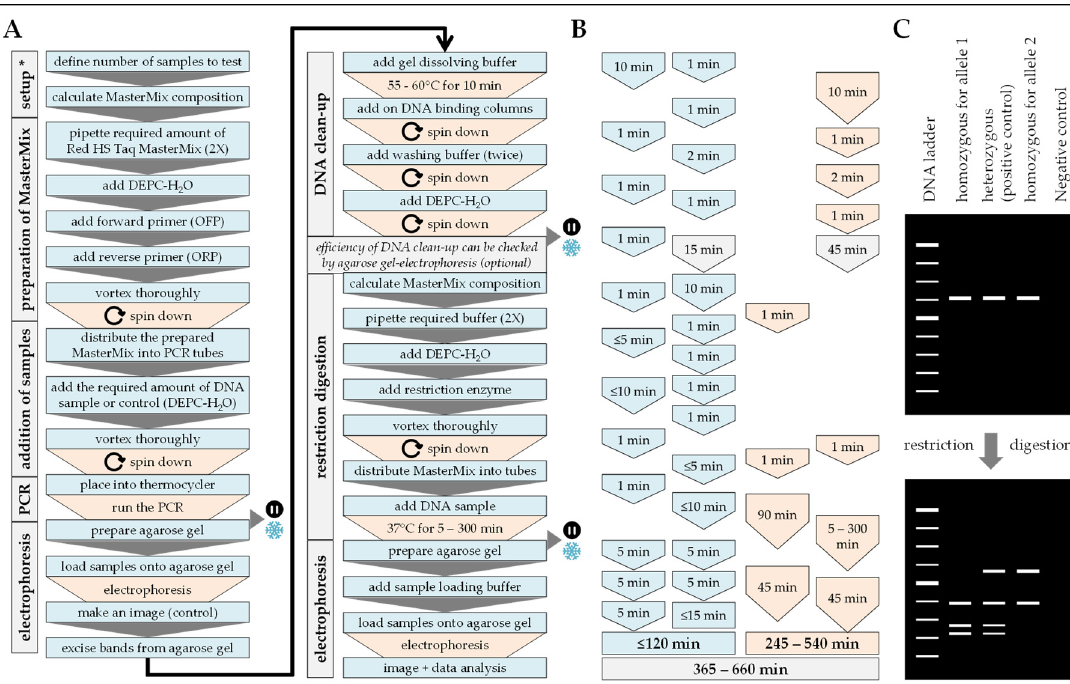
Table 2. Primer sequences used to detect SNPs of the PADI4 gene and resulting amplicon lengths. SNP Primer